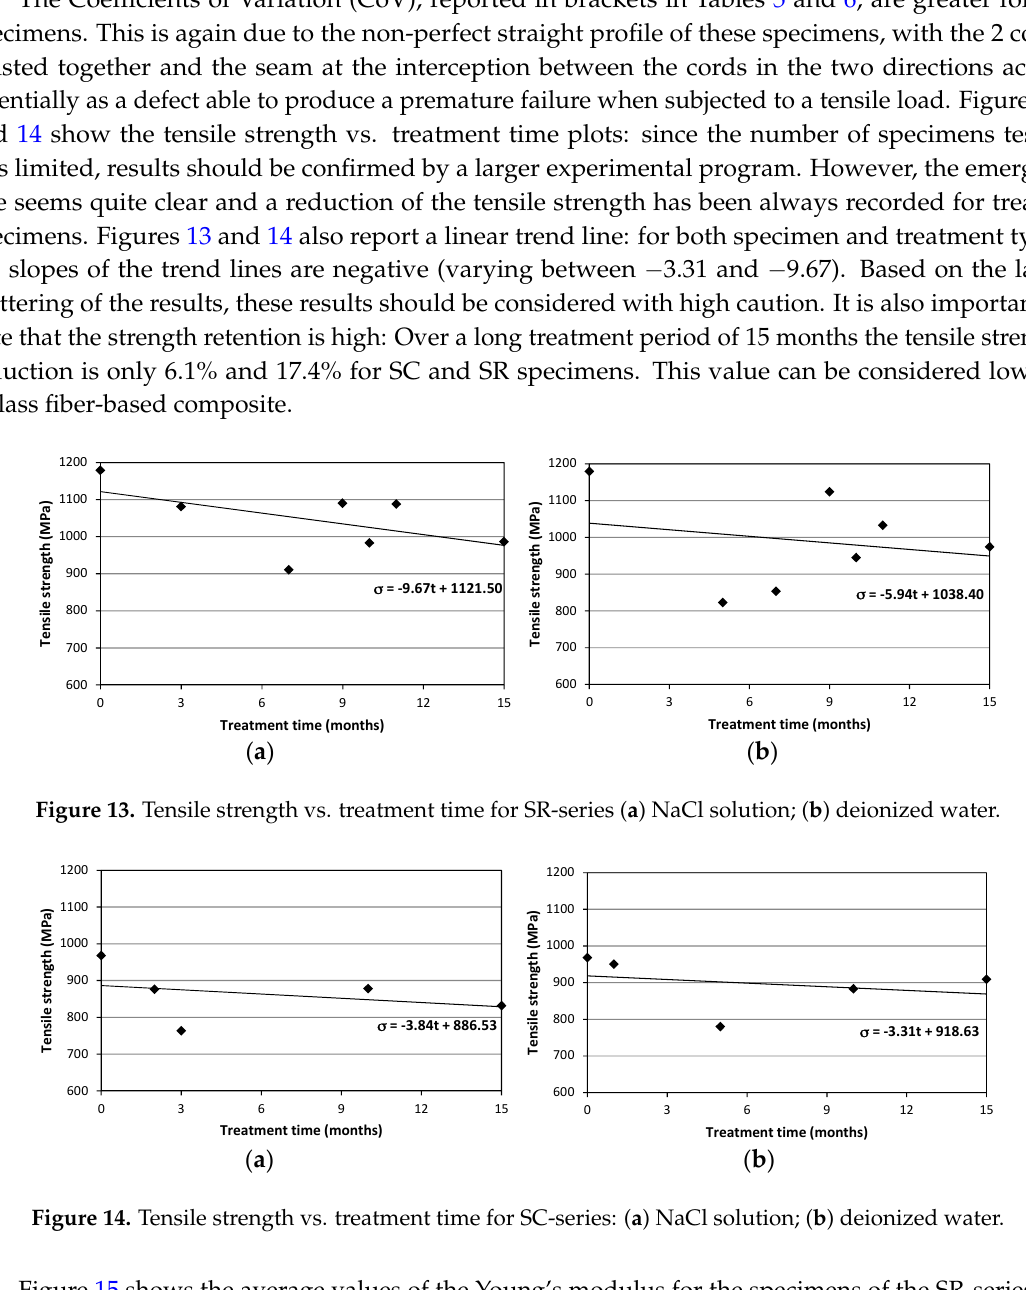
Figure 15. Young’s modulus vs. treatment time for SR-series ( a ) NaCl solution; ( b ) deionized water.